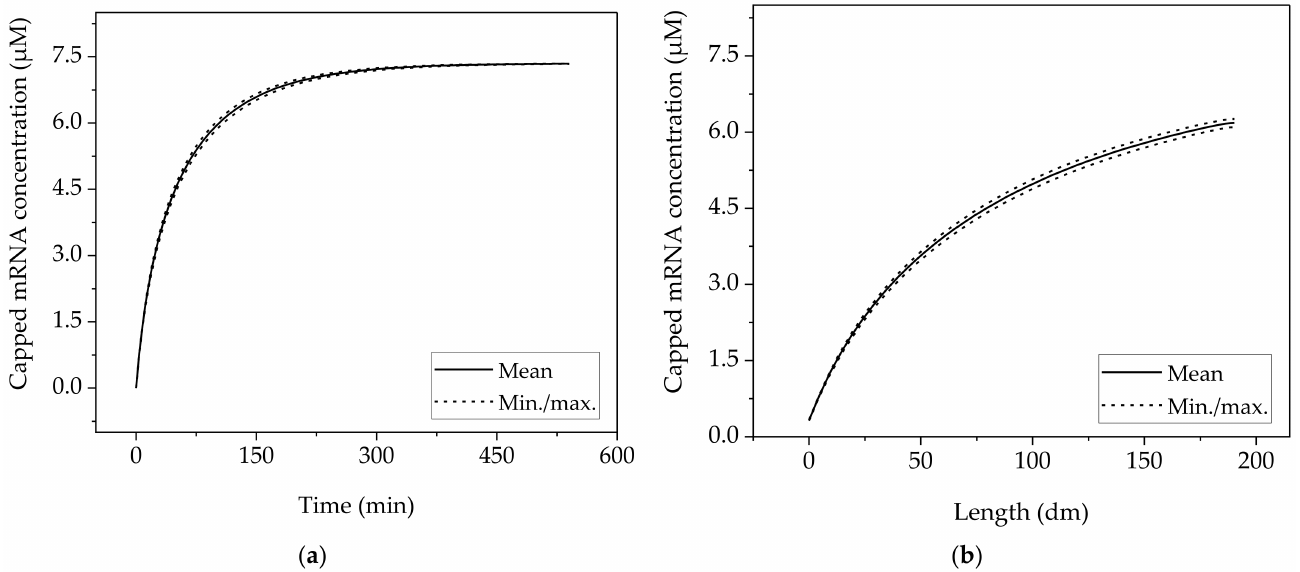
Figure 7. Concentration profiles obtained by Monte-Carlo simulations. ( a ) Batch reactor; ( b ) Tubular reactor